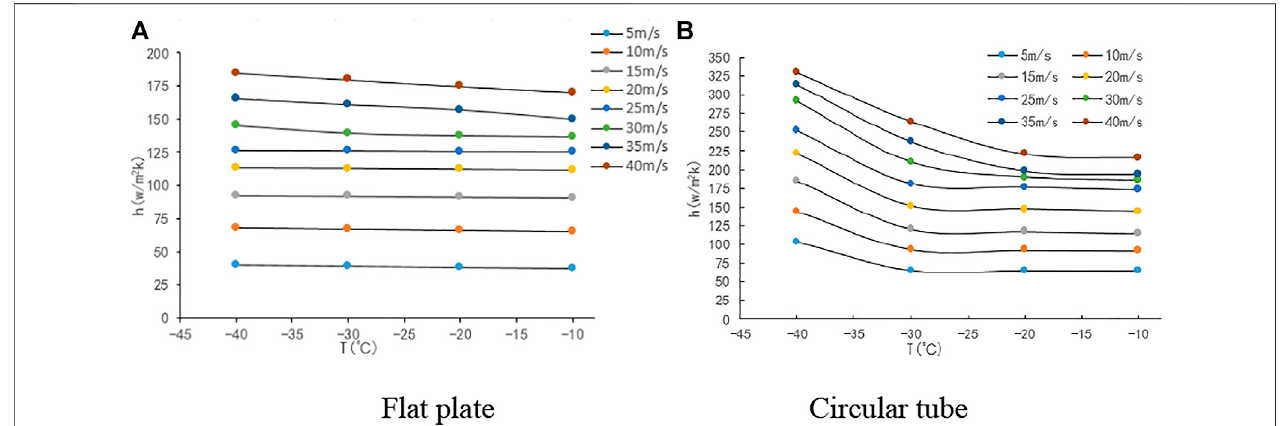
FIGURE 3 | Change of convective heat transfer coef fi cient with environment temperature. (A) Flat plate and (B) Circular tube.